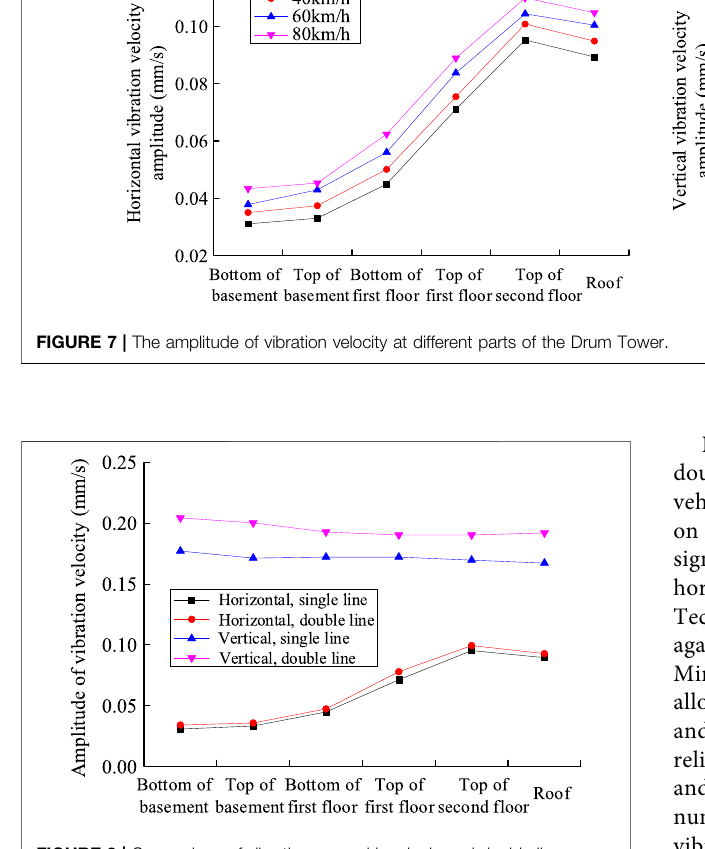
FIGURE 8 | Comparison of vibration caused by single and double line